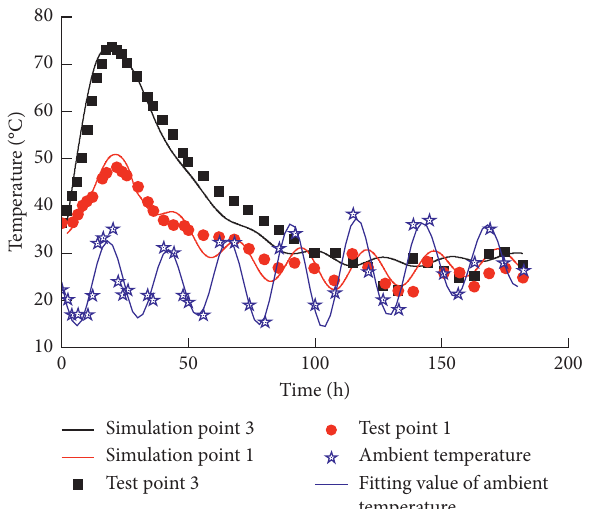
Figure 15: Comparison of simulated data and measured data on points 1 and 3.